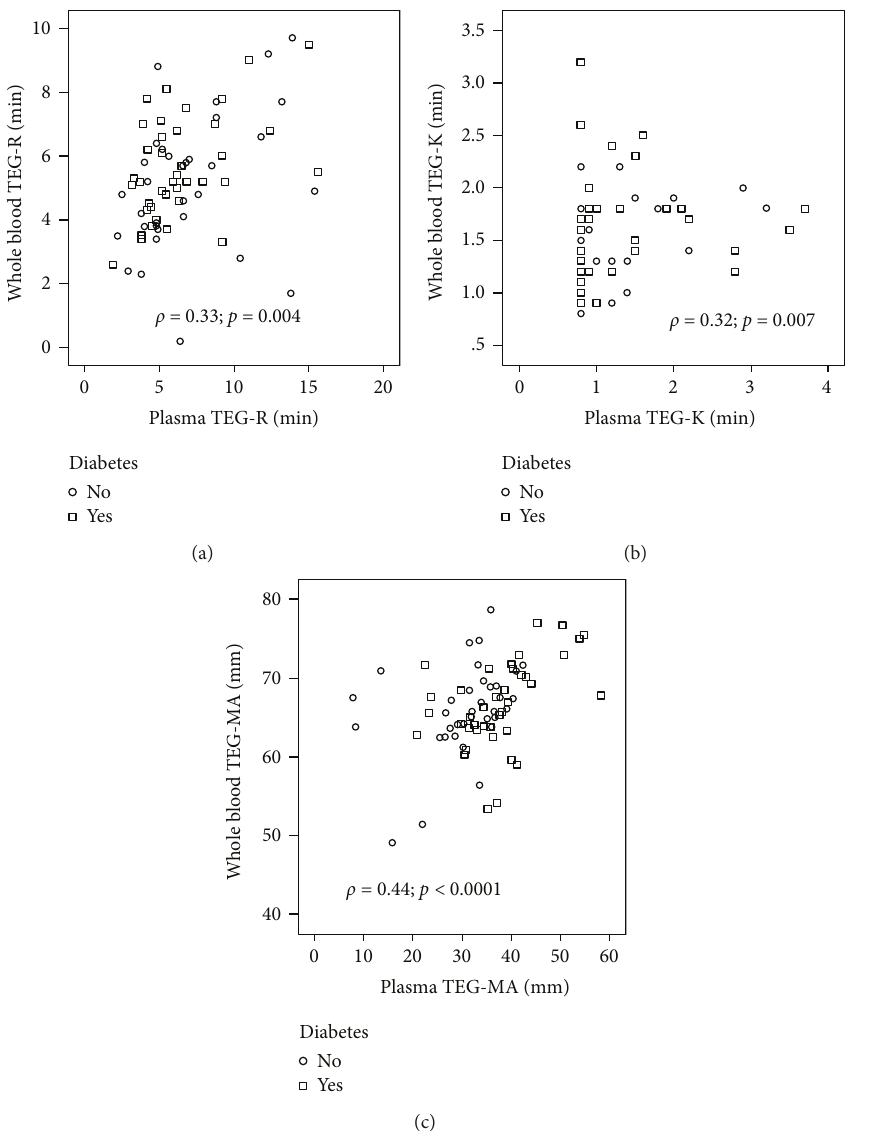
Figure 2: Correlation between whole blood and platelet-poor plasma TEG measurements in a subgroup of the overall study population ( n = 74 ) divided between subjects with and without diabetes mellitus. (a) TEG-R: time to fi brin formation. (b) TEG-K: clot formation time. (c) TEG-MA: maximal clot